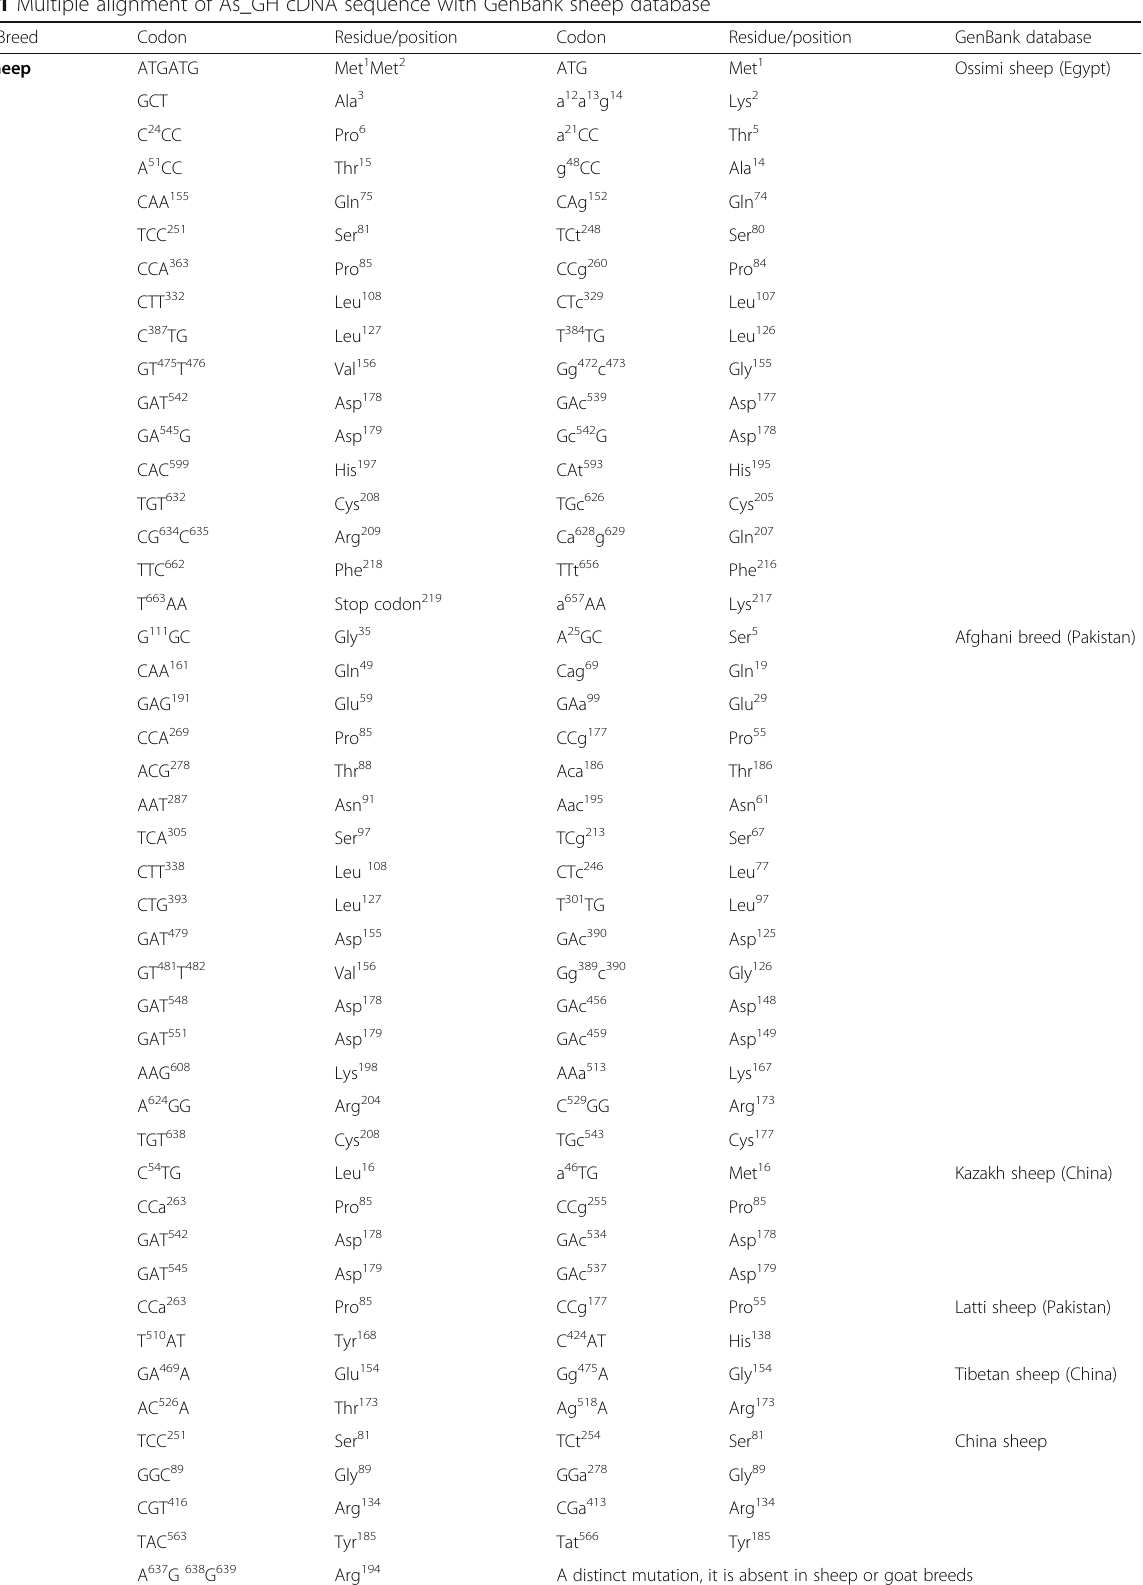
Table 1 Multiple alignment of As_GH cDNA sequence with GenBank sheep database Current